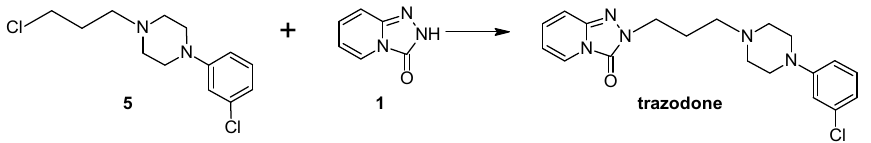
Scheme 6. Synthesis of trazodone with method II under MW radiation.